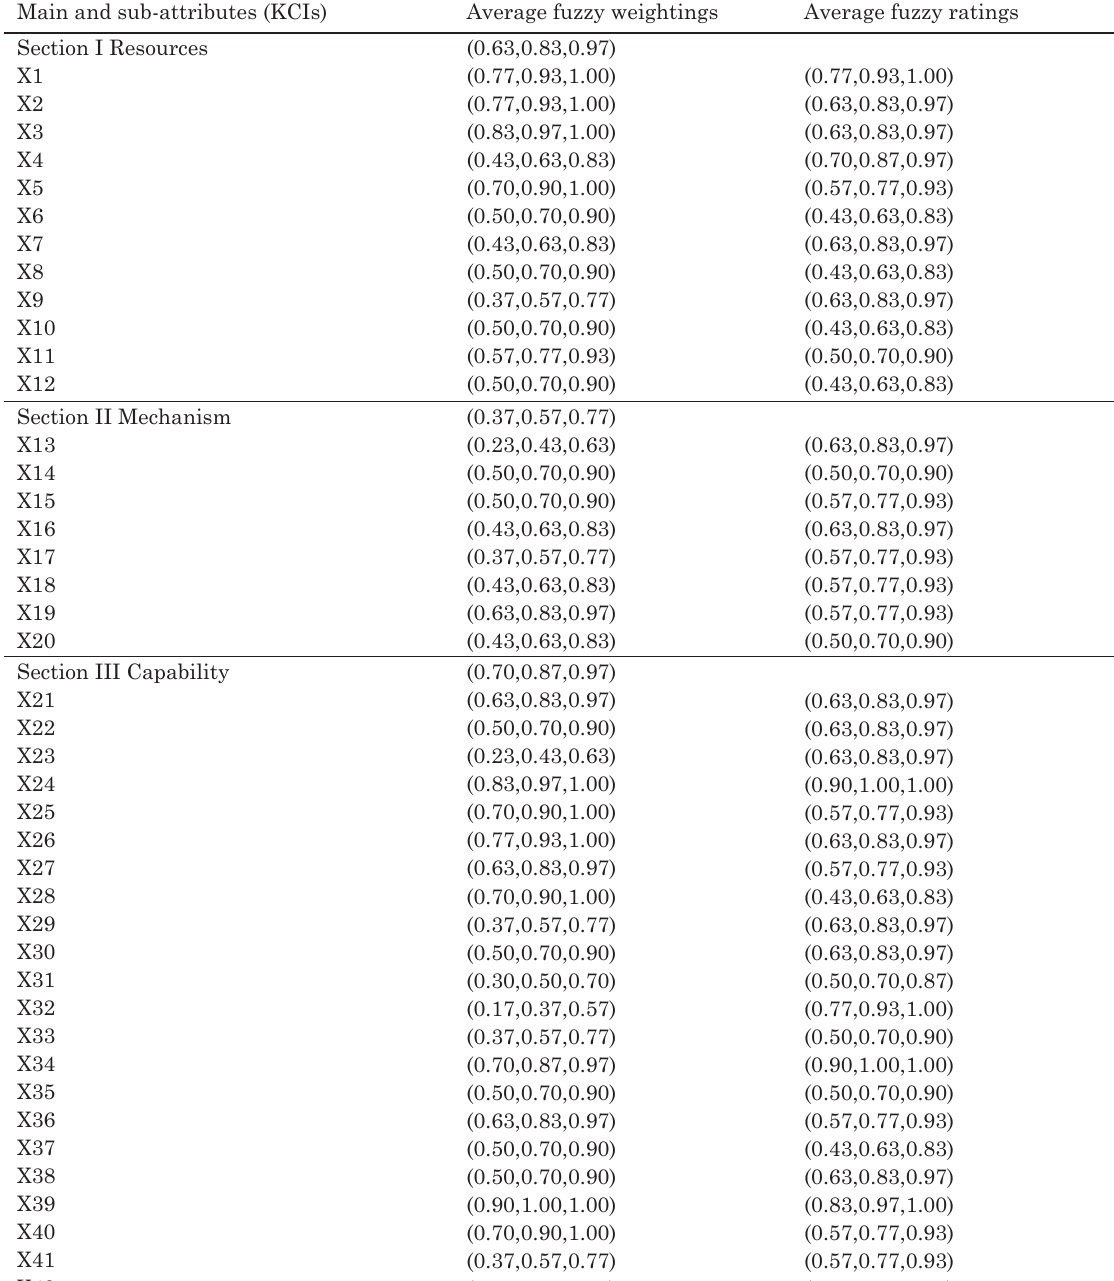
table 6. average fuzzy ratings and fuzzy weightings of competitiveness attributes Main and sub-attributes